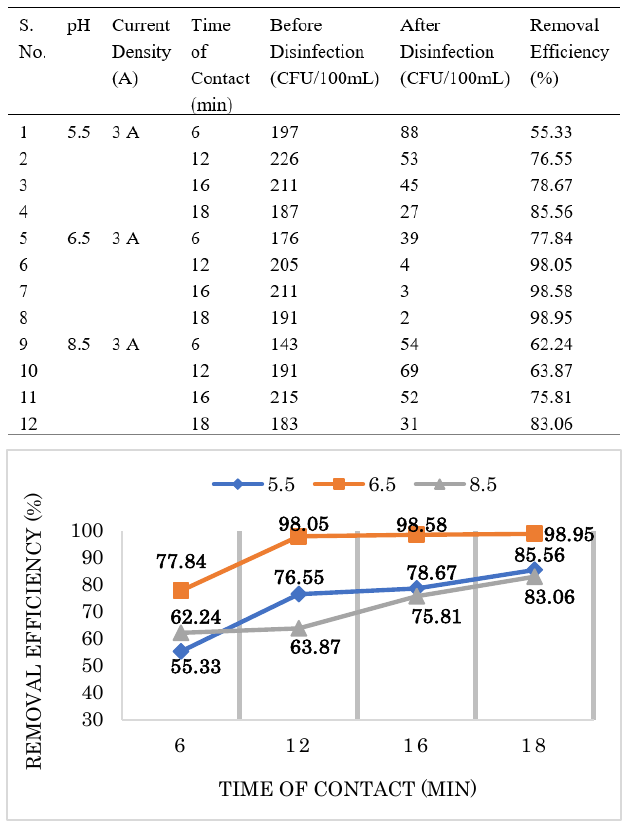
Fig. 9. Time optimization for total coliform removal for 3 A